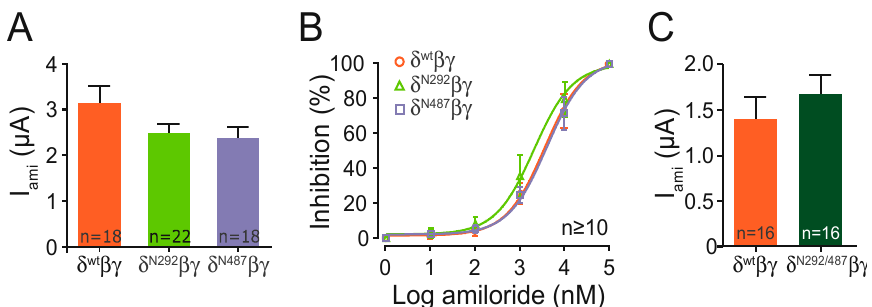
Figure 4. Insertion of N-glycosylation sites in δ ENaC does not impair channel function. ( A ) ENaC mediated amiloride-sensitive whole-cell currents (I ami ) of δ N292 βγ and δ N487 βγ were comparable to δ wt βγ ENaC (one-way ANOVA with multiple comparisons). ( B ) Half-maximal amiloride concentrations for δ N293 and δ N487 constructs were also comparable to wt. ( C ) ENaC mediated currents (I ami ) of δ N292/N487 βγ channels were similar to wt channels (unpaired t -test).